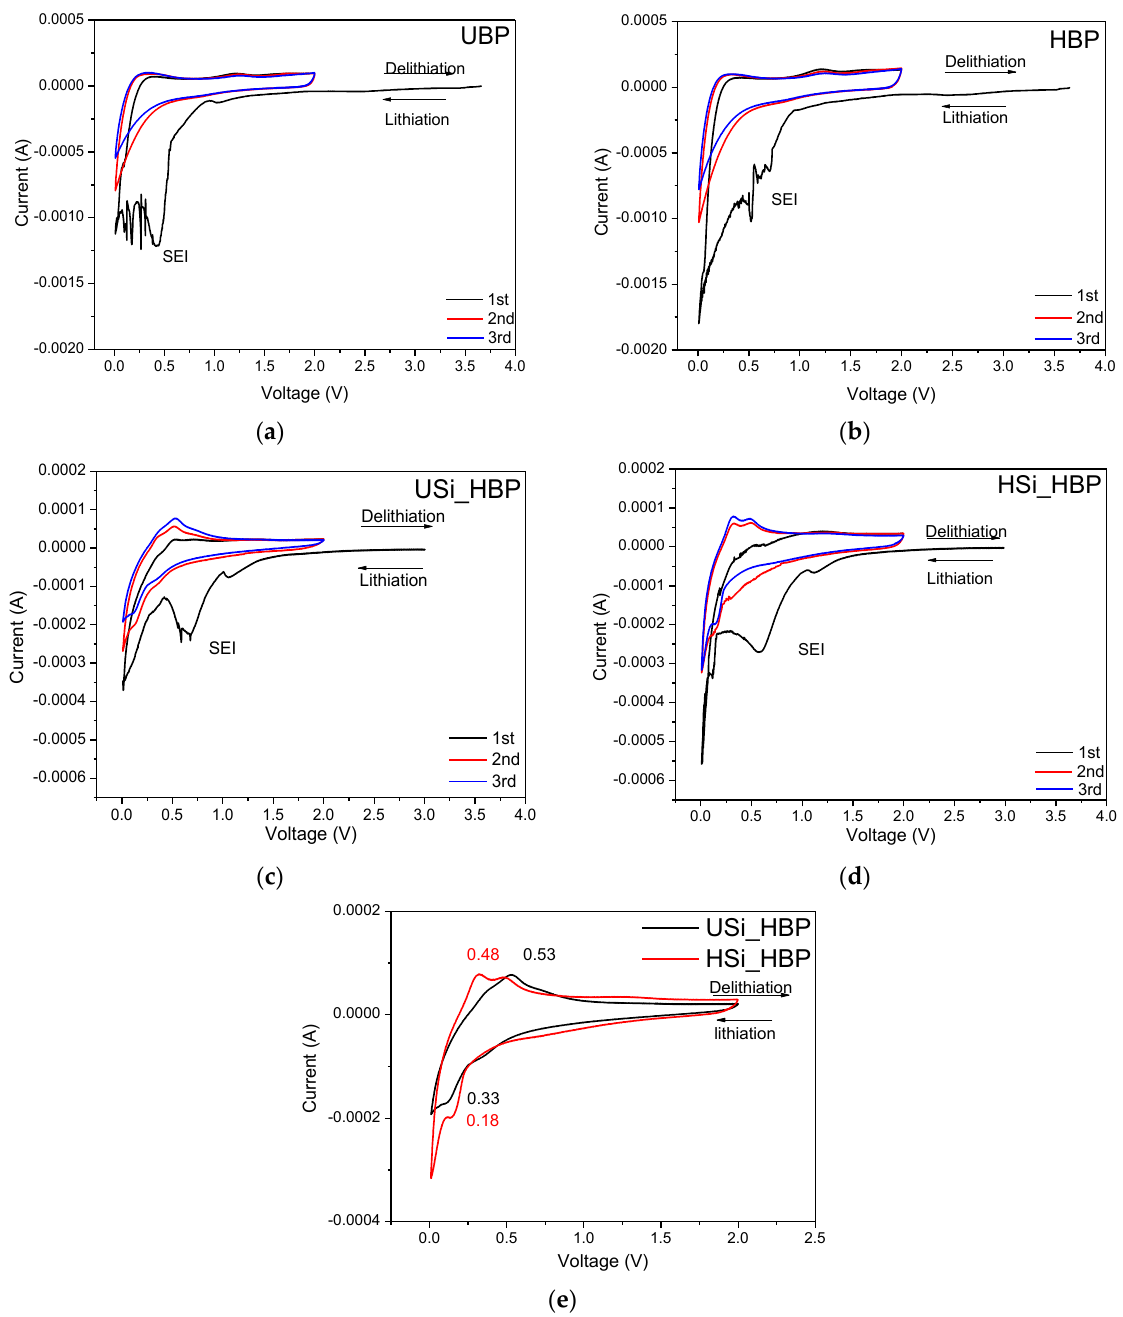
Figure 6. The cyclic voltammograms of ( a ) the UBP, ( b ) HBP, ( c ) USi_HBP, and ( d ) HSi_HBP electrodes; ( e ) third CV curves of both Si electrodes at a 0.1 mV s −1 scanning rate between 0.01 and 2.0 V.